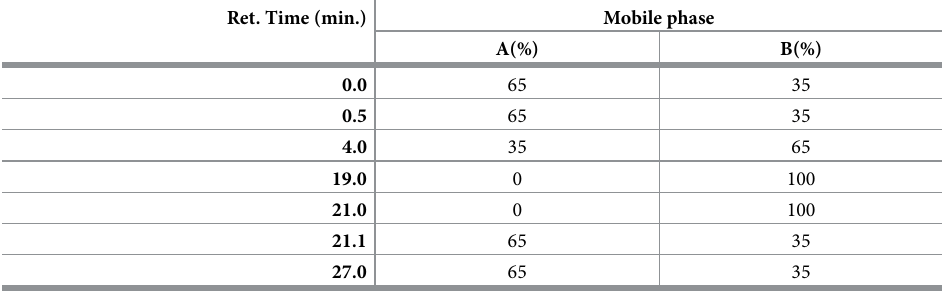
Table 3. Binary gradient used during LC-MS analysis of spat TLE. Mob A: Water + 10 mM Ammonium formate + 20 mM Formic acid; Mob B: IPA:ACN (9:1) + 10 mM ammonium formate + 20 mM formic acid. Ret. Time